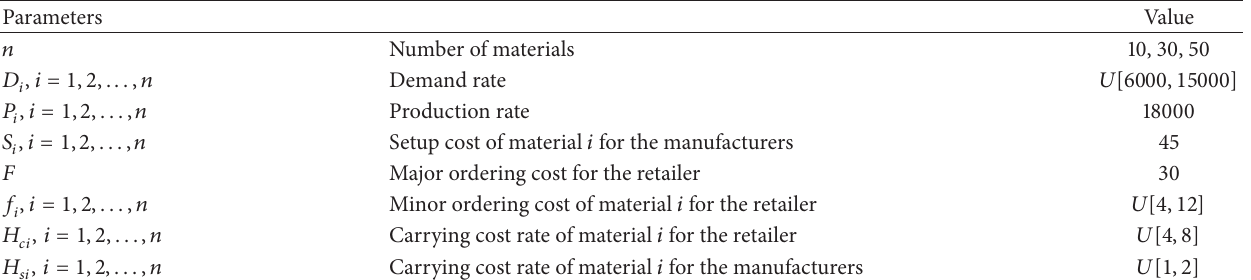
Table 6: Parameters for the extended